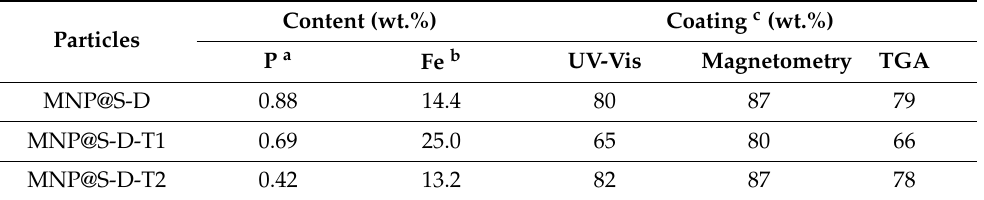
Table 2. Results of UV-Vis analysis and AAS of MNP modified with poly[2-(dimethylamino)ethyl methacrylate] and poly[2-(dimethylamino)ethyl methacrylate- co -2- tert -butylaminoethyl methacrylate]. Content (wt.%) Coating c (wt.%) Particles P a Fe b UV-Vis Magnetometry TGA MNP@S-D 0.88 14.4 80